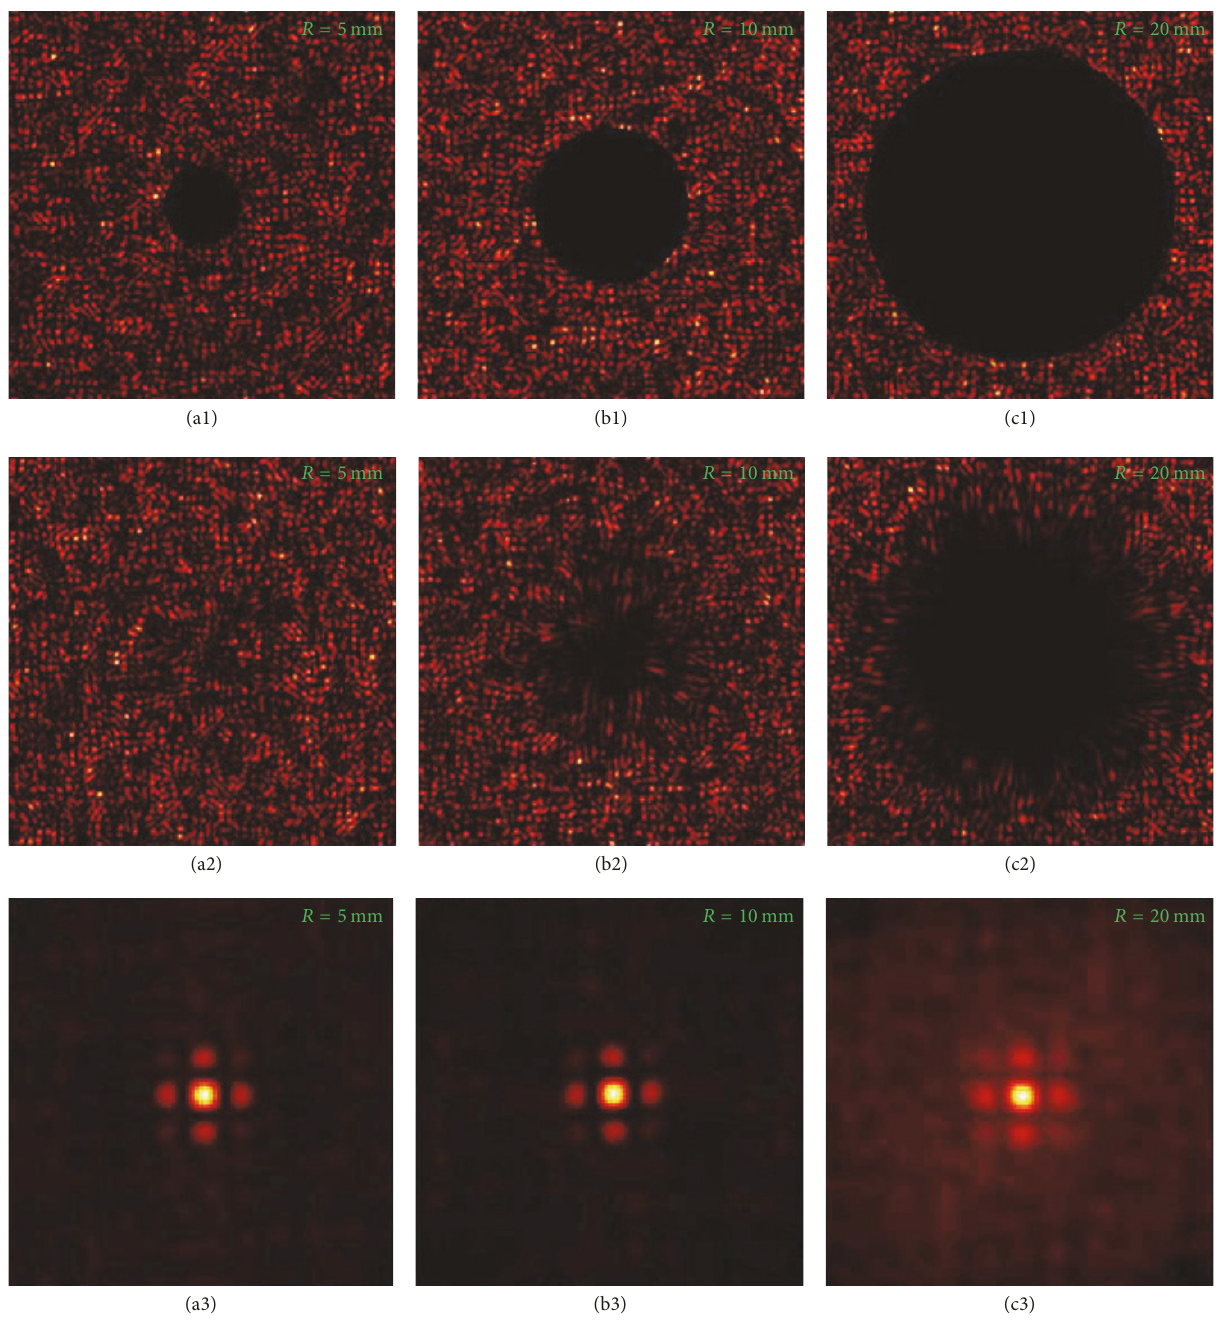
Figure 4: The simulation of speckle pattern and corresponding to the autocorrelation for different size of obstruction with 𝛿 = 6 mm ; 𝑛 = 1 . The first row denotes the speckle pattern in the source plane, the second row denotes the speckle pattern in the plane of 𝑧 = 16 m, and the third row denotes the autocorrelation of the speckle pattern in the second